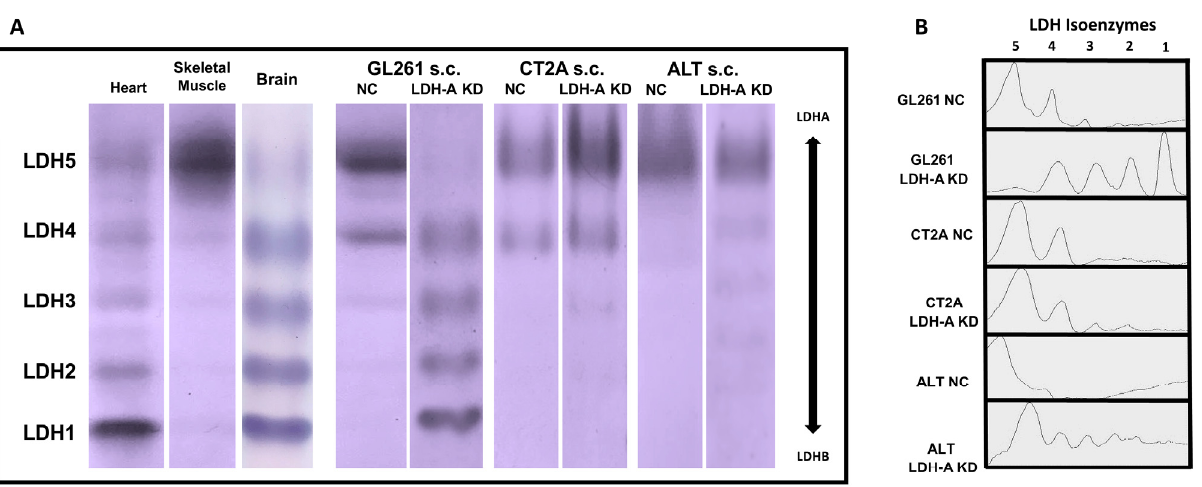
Figure 6. Native-polyacrylamide gel electrophoresis LDH zymograms for ex vivo tissue and s.c. GL261, CT2A and ALTS1C2 tumors. Electrophoretic patterns in the heart and skeletal muscle as well as s.c. tumors from NC and LDH-A KD GL261, CT2A and ALTS1C1 tumors (Panel A ), corresponding LDH isoform profiles (Panel B ); n = five independent